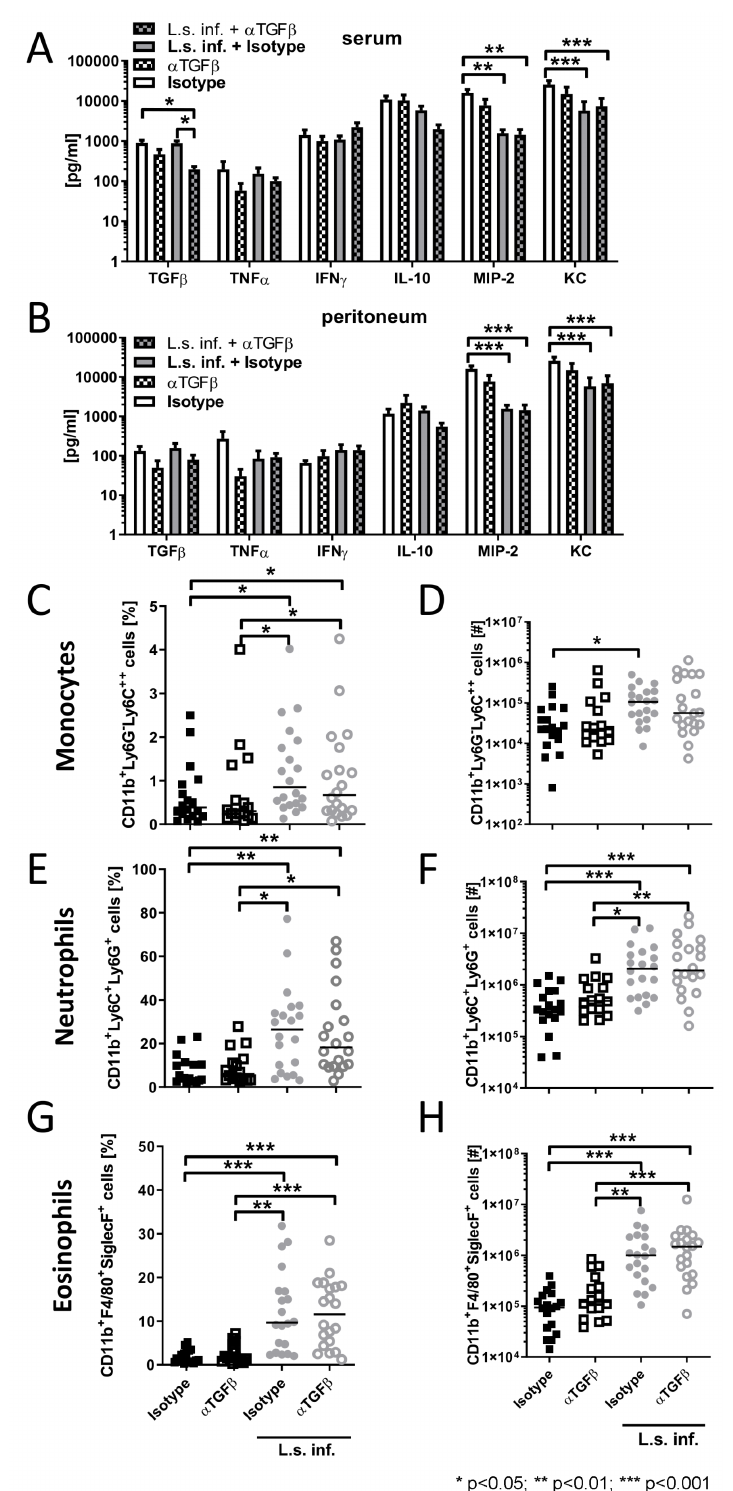
Figure 3: TGFβ depletion does not alter pro-inflammatory cytokine/chemokine production, peritoneal composition of monocytes, neutrophils and eosinophils during SIRS and their expansion in L.sigmodontis-infected mice. (A) Serum and (B) peritoneal cytokine/chemokine levels six hours after E. coli injection. (C,D) Relative and absolute number of peritoneal CD11b + Ly6G – Ly6C ++ monocytes, (E,F) CD11b + Ly6G + Ly6C + neutrophils and CD11b + F4/80 med SiglecF + eosinophils (G,H) six hours after E. coli injection in mice that were infected for 90 days with L. sigmodontis and uninfected controls and received either anti-TGFβ or an isotype control before E. coli challenge. Data represent three pooled independent experiments with at least six mice per group. Data are shown as mean +SEM (A,B) and median (C–H) and was tested for statistical significance by Kruskal-Wallis test and Dunn’s Multiple Comparison post hoc